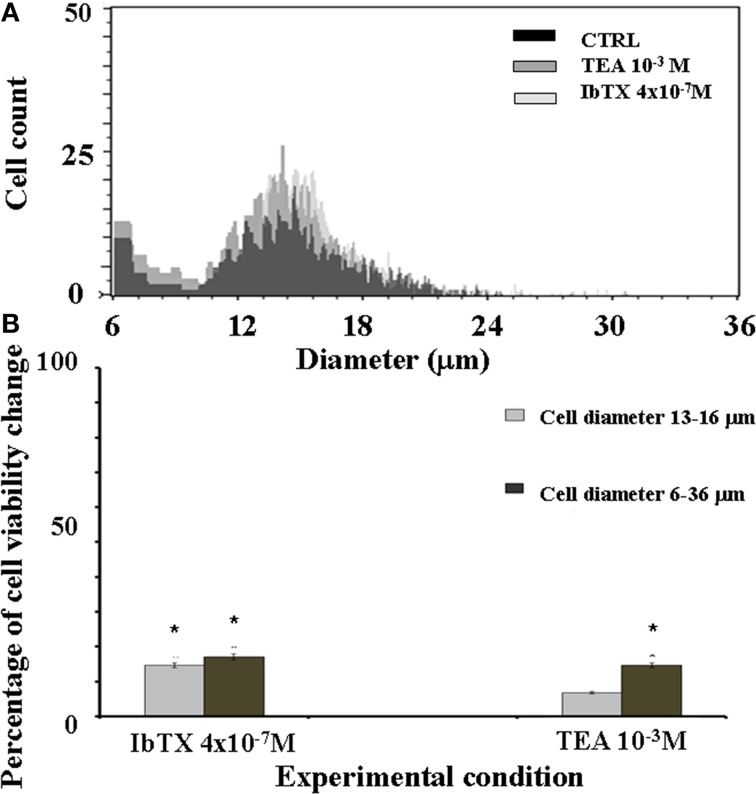
SH-SY5Y neuronal cell distribution in the presence or absence of the BKCa channel blockers IbTX and TEA. The effects of the IbTX and TEA on the cell volume were investigated. The cellular distribution followed a Gaussian type distribution (A) The most frequently observed cell population in our experimental condition showed a diameter size in the range of 13–16 μm as determined by cell volume assay. The mean cell diameter did not significantly differ between treatments, the values were 14.89 ± 1 in the controls (CTRL) and were 15.02 ± 2 and 14.5 ± 1, respectively, in the cells treated with IbTX and TEA (B) After 6 h of incubation time the number of the cells showing a diameter size in the range of 13–16 μm was significantly enhanced by IbTX and TEA. *Data significantly different with respect to the controls for p < 0.05 as determined by student t-test.